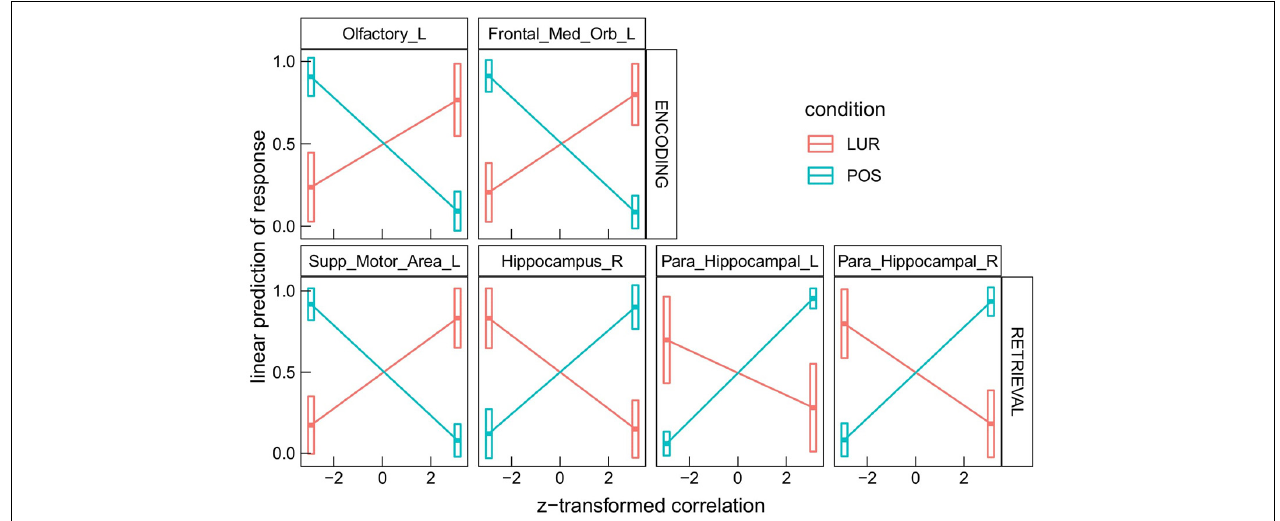
FIGURE 3 | Results of the correlation × phase × probe × ROI interaction in the global processing task, averaged over condition levels. Horizontal bars are 95%